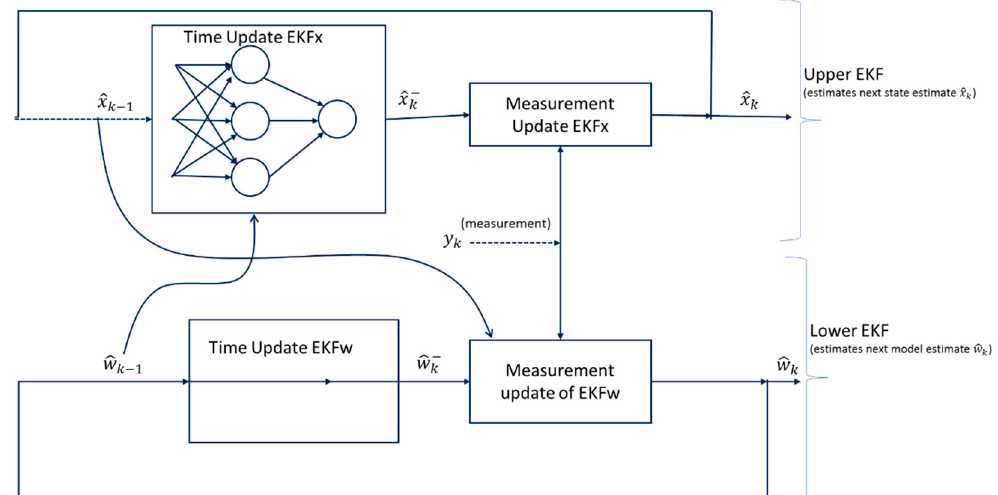
Figure 8. The dual extended Kalman filter. The method utilizes two concurrently running EKFs. State estimates are done by the top EKF using ˆ w k − 1 for the time update, while weight estimates are generated using the bottom EKF that does measurement updates using ˆ x k − 1